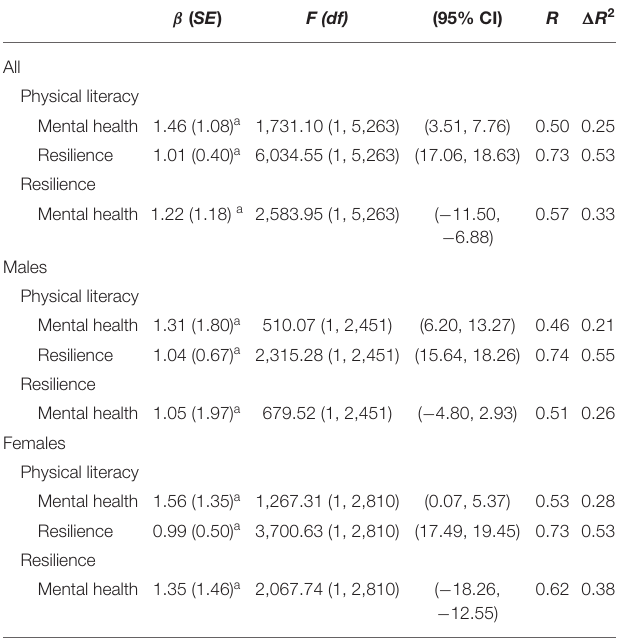
TABLE 1 | Results of the standard linear regression analysis among physical literacy, mental health, and resilience. β ( SE )